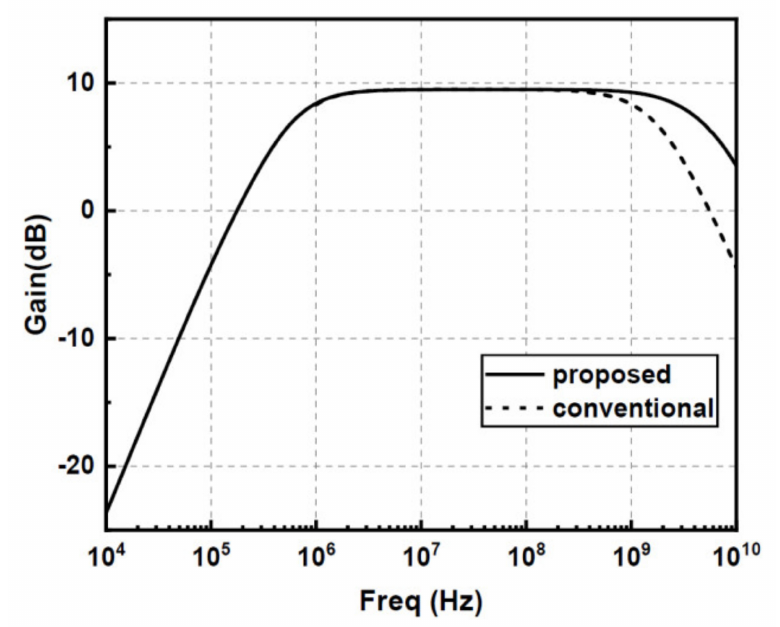
Figure 9. The simulated frequency response results of the proposed and the conventional gain